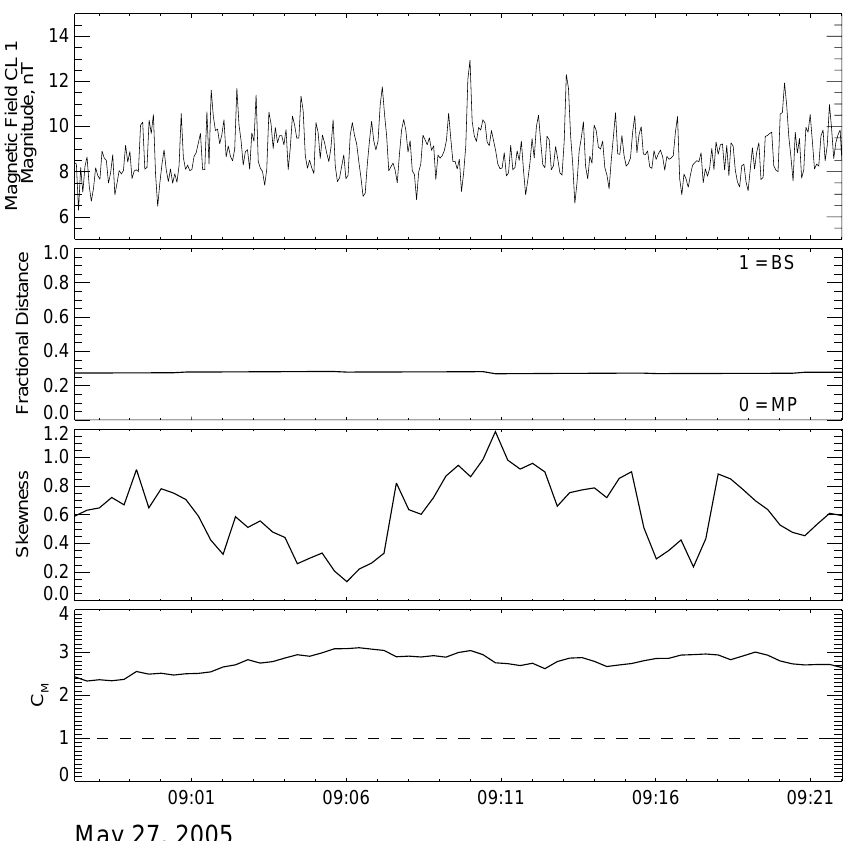
Fig. 7. Observations of magnetic peaks by Cluster 1 on 27 May 2005 (same panels as in Fig. 1).